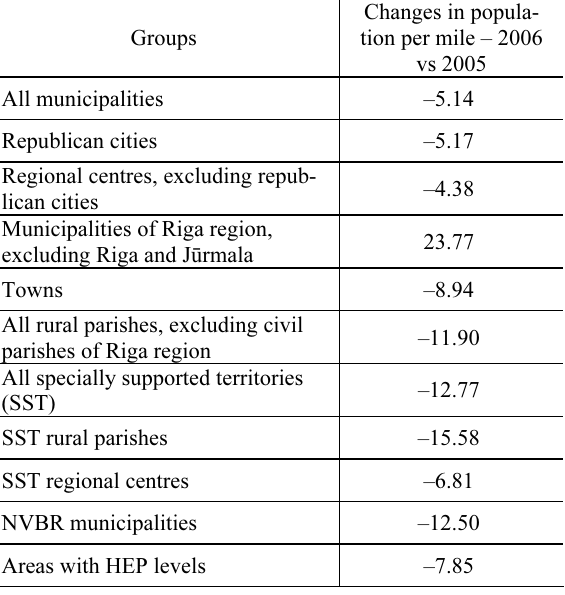
Table 3. Changes in population per mile in studied groups